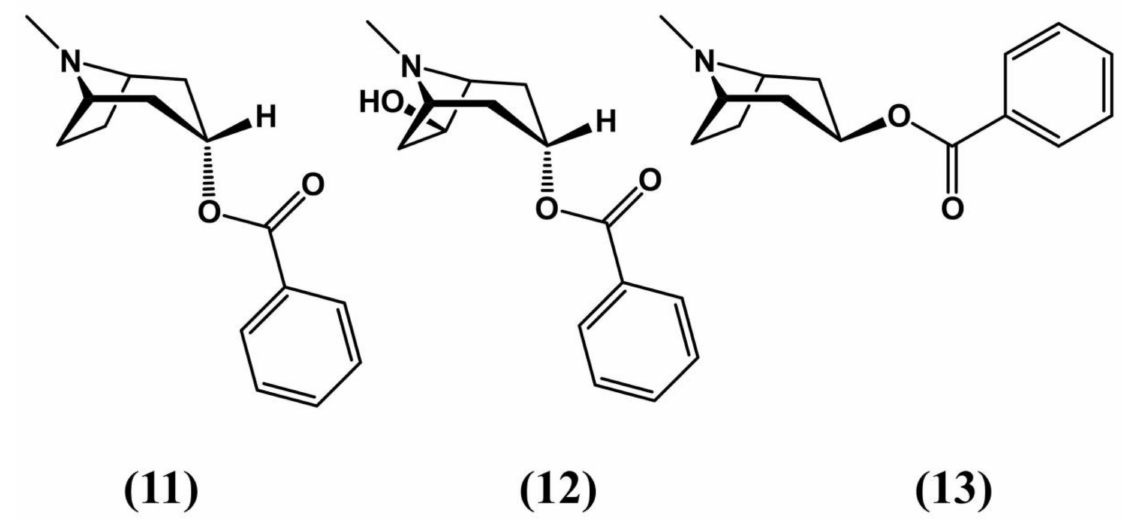
Figure 6. Examples of tropanes found in Erythroxylum macrocarpum